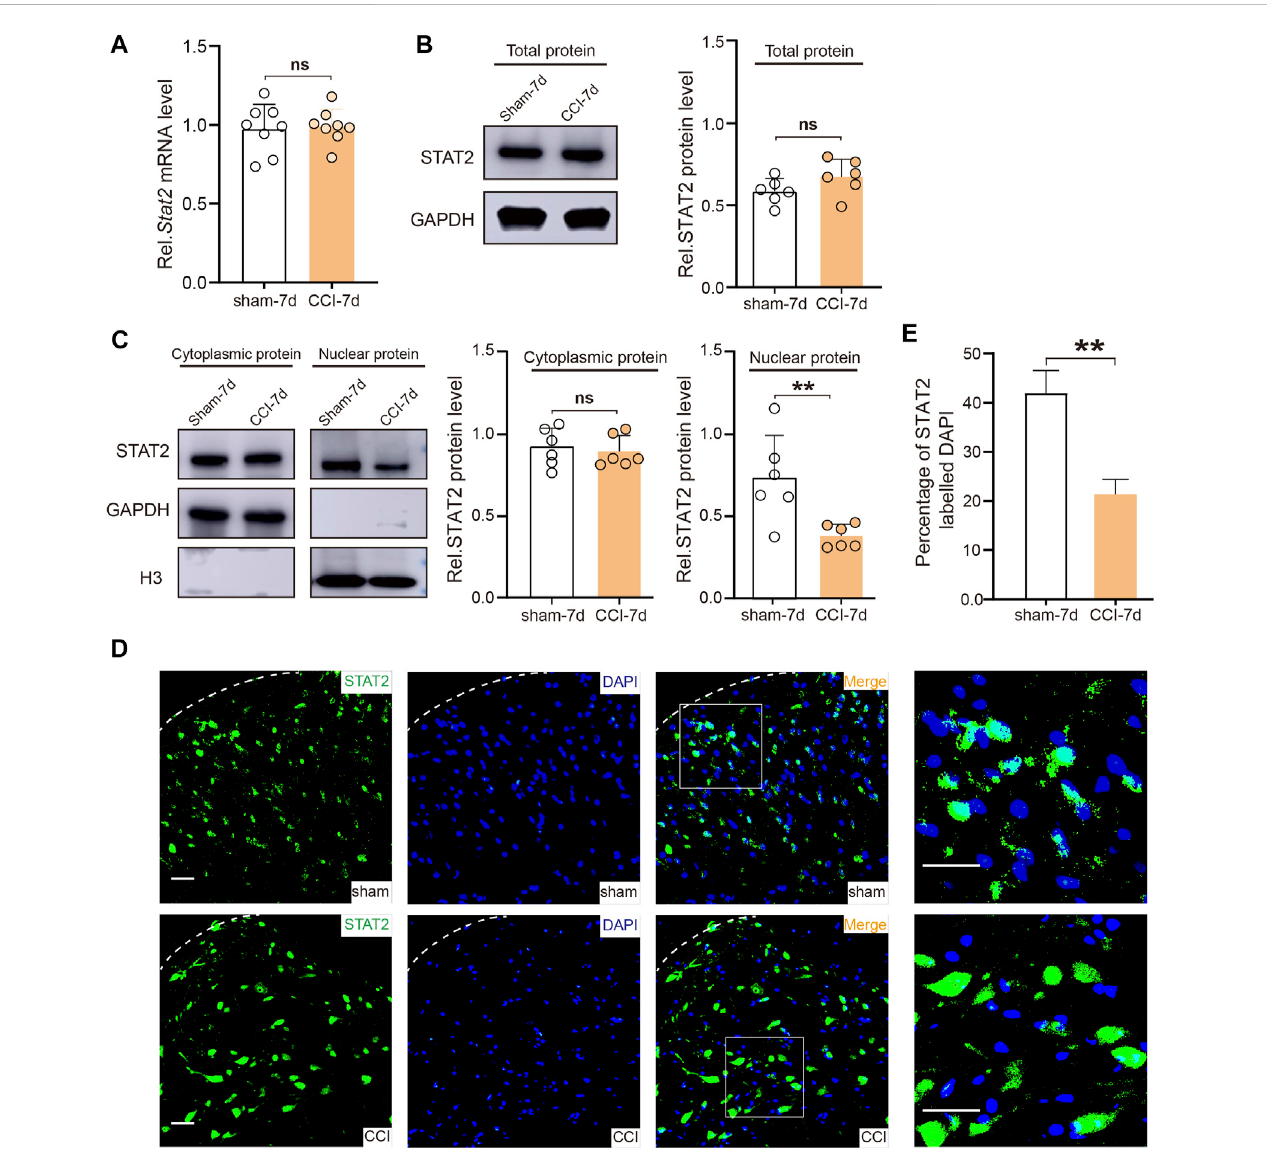
FIGURE 3 Chronic constriction injury (CCI) downregulated STAT2 in spinal dorsal horn (SDH) nuclei. (A) The mRNA expression of Stat2 in the SDH was not altered afterCCIsurgery( n =8,two-tailedunpairedStudent ’ st-test). (B) STAT2proteinexpressionintheSDHoftheCCIgroupwasnotdifferentfromthatinthesham group(proteinexpressionwasnormalizedtotheGAPDHlevel)( n =6,two-tailedunpairedStudent ’ st-test). (C) STAT2proteinexpressionintheSDHoftheCCI group was decreased in the nuclear fraction (protein expression was normalized to the H3 level) but not different from in the cytoplasmic fraction (protein expression was normalized to the GAPDH level) compared to the sham group ( n = 6, ** p < .01, two-tailed unpaired Student ’ s t-test). (D) Immuno fl uorescence staining of STAT2 (green) and DAPI (blue) in the injured ipsilateral SDH on day 7 after sham or CCI surgery (scale bar = 50 µm). (E) The proportionofSTAT2co-localizedwithDAPI(nuclearmarker)wasdecreasedintheipsilateralSDHafterCCIsurgery(comparedwithsham-operatedrats,** p < .01, n = 3, two-tailed unpaired Student ’ s